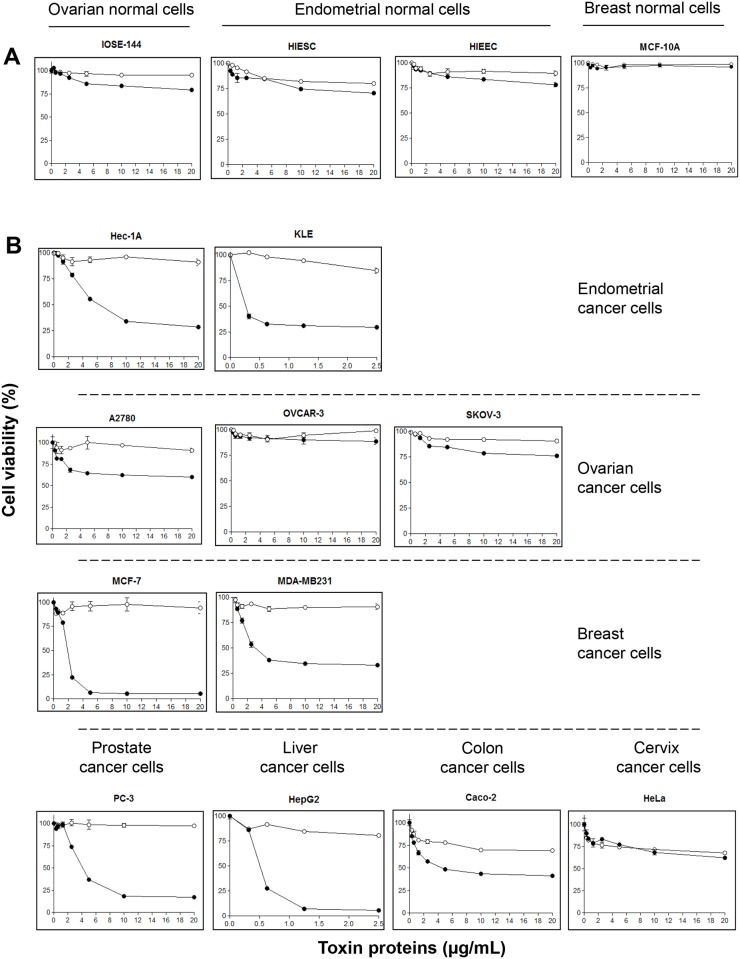
Cytocidal activities of Bacillus thuringiensis 4R2 toxin proteins.Normal cultured human cells (A) and cancer cultured human cells (B) (2 X 104 cells) were preincubated at 37°C for 20h; the toxin treated with trypsin (○) or proteinase K (●) was added (final concentrations, 0.3μg/mL to 20μg/mL) further incubated for 24h. Cell proliferation was assayed using MTT.